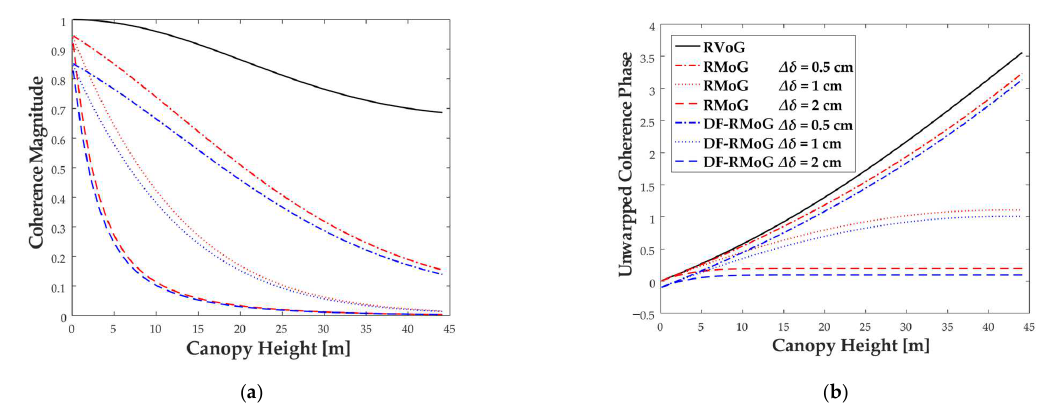
Figure 4. Relationship of canopy height and different parameters with RVoG, RMoG, and DF-RMoG models. ( a ) Relationship of canopy height and coherence magnitude. ( b ) Relationship of canopy height and unwrapped phase.